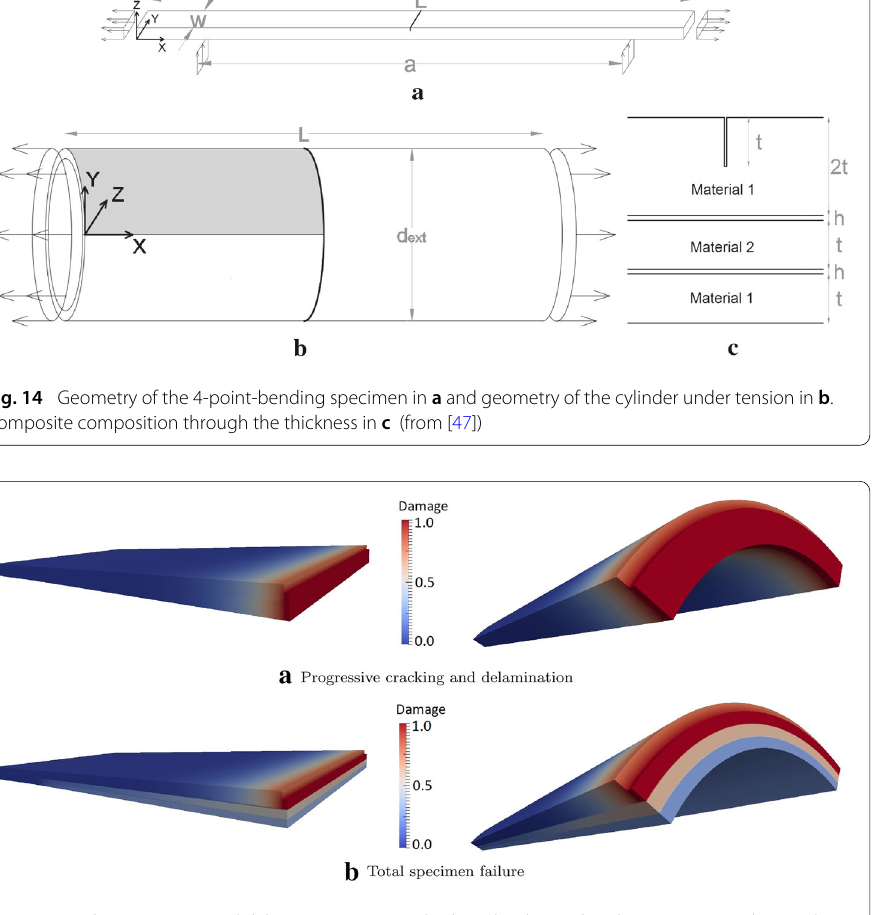
Fig. 15 Crack propagation and delamination in a notched sandwich panel. a Flat geometry under tensile and 4-point banding loading; b cylindrical geometry under tensile loading (from